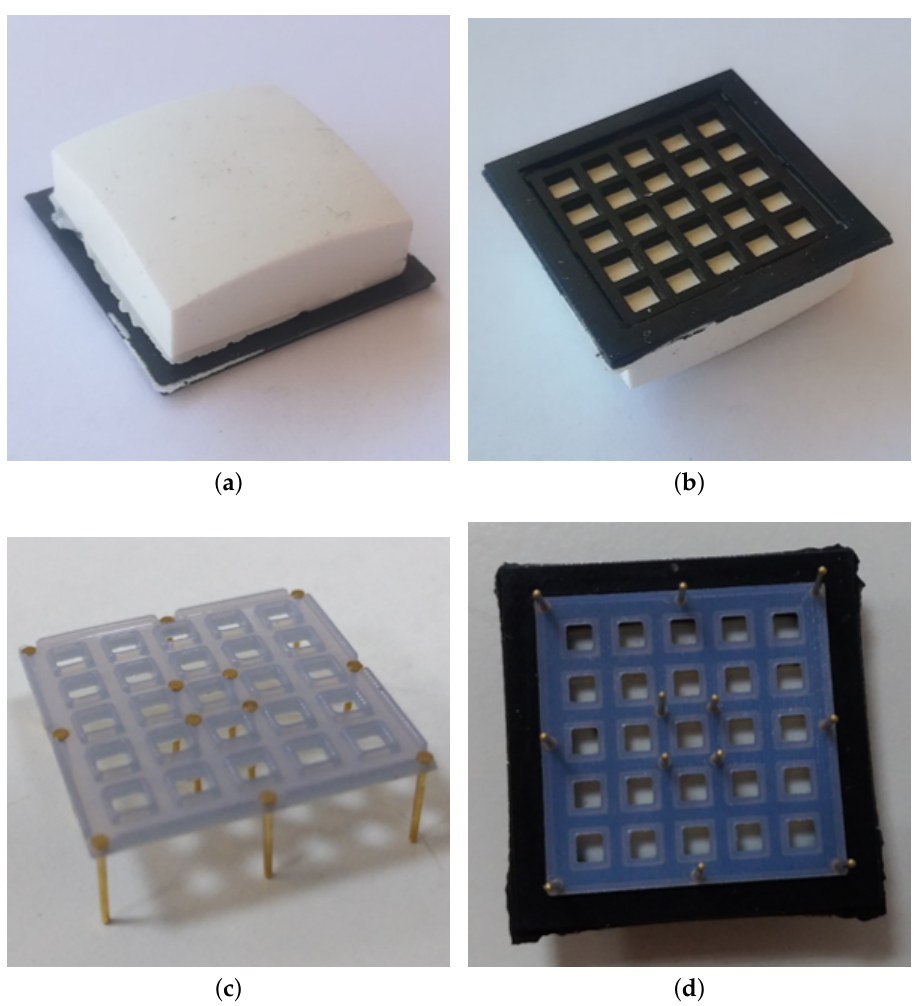
Figure 3. Pictures of deformable layer and rigid grid: Top view ( a ) and bottom view ( b ) of the deformable layer, grid with bonded pins ( c ) and deformable layer assembled with the grid ( d